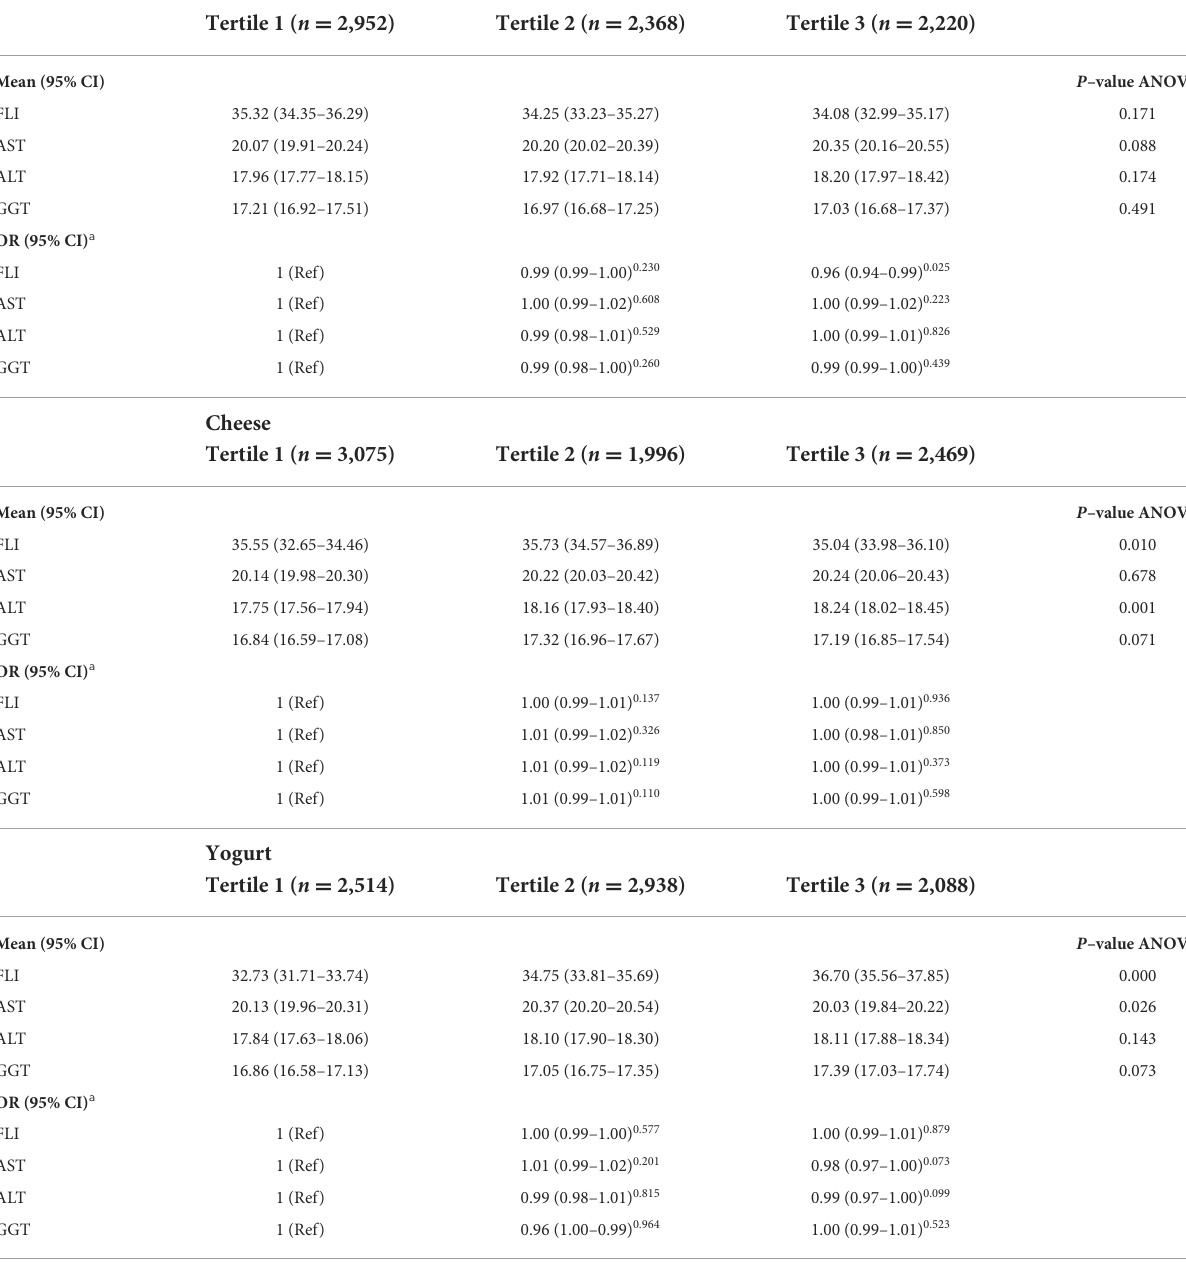
TABLE 4 Univariate and multiple analyses to determine the independent association between fatty liver index and dairy consumption. Milk Tertile 1 ( n = 2,952) Tertile 2 ( n = 2,368) Tertile 3 ( n =